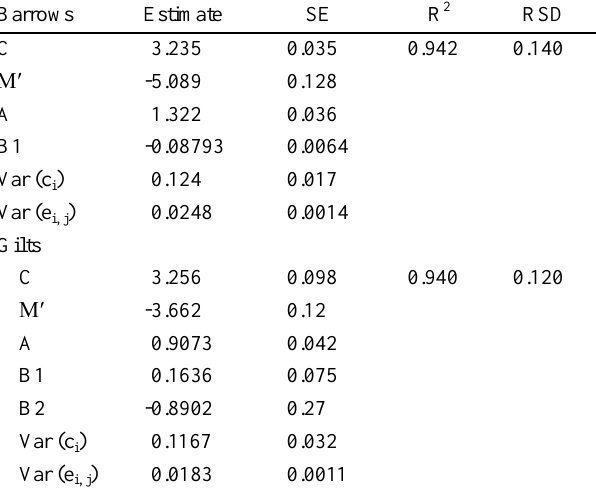
Table 7. Parameters and statistics for Bridges Function fitted